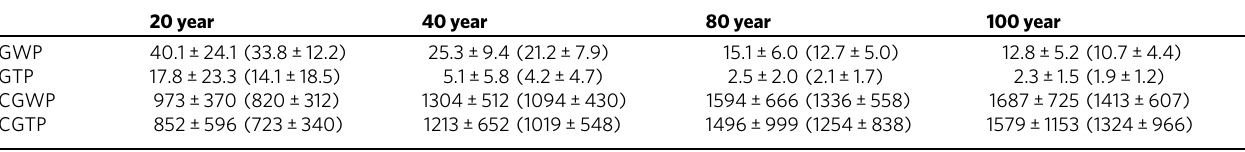
Table 1 GWP, GTP, CGWP, and CGTP metrics for hydrogen at 20, 40 and 80 and 100-year